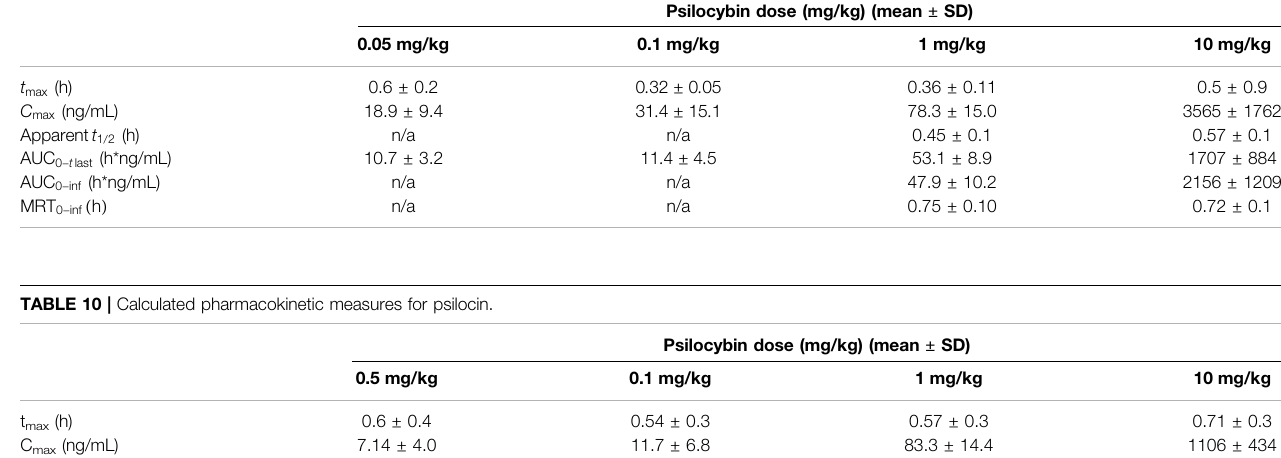
TABLE 9 | Calculated pharmacokinetic measures for psilocybin.